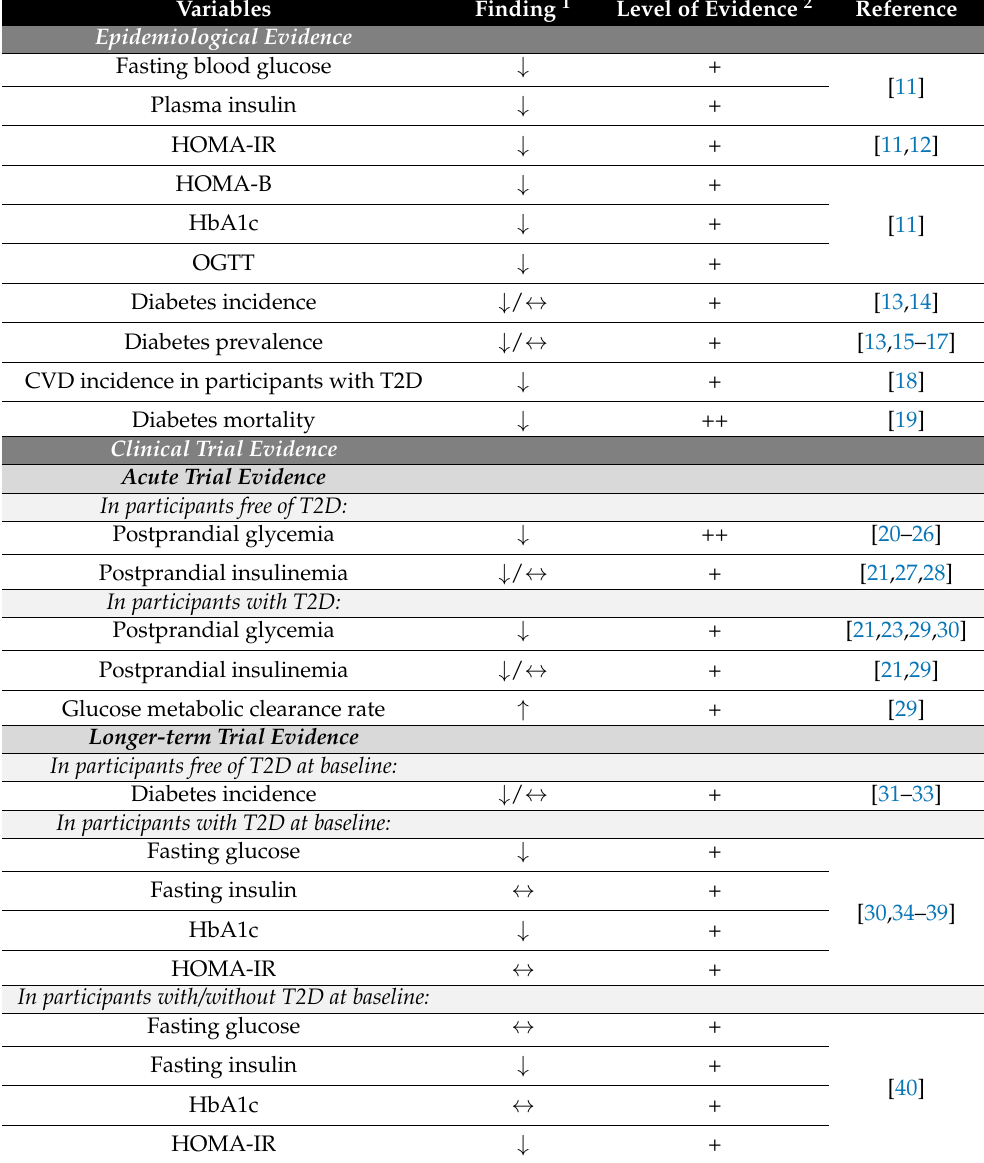
Table 1. Summary of findings related to nuts and diabetes related prevention and